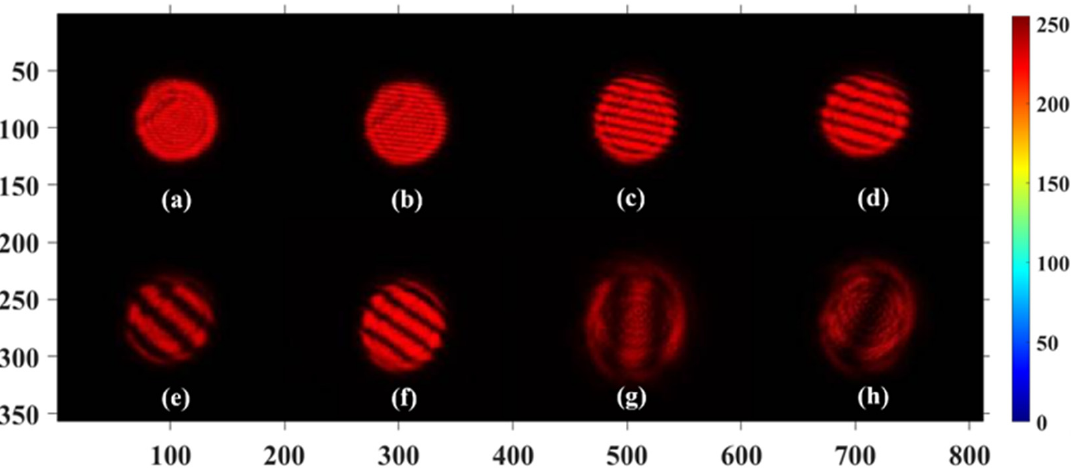
Figure 12. Experimental results ( a – h ) of unparallel two vector beams with the same shape combining in free space. The width-of-stripes pattern varies with the degree of parallelization of the two beams. When the beam alignment is well performed but two beams are not completely